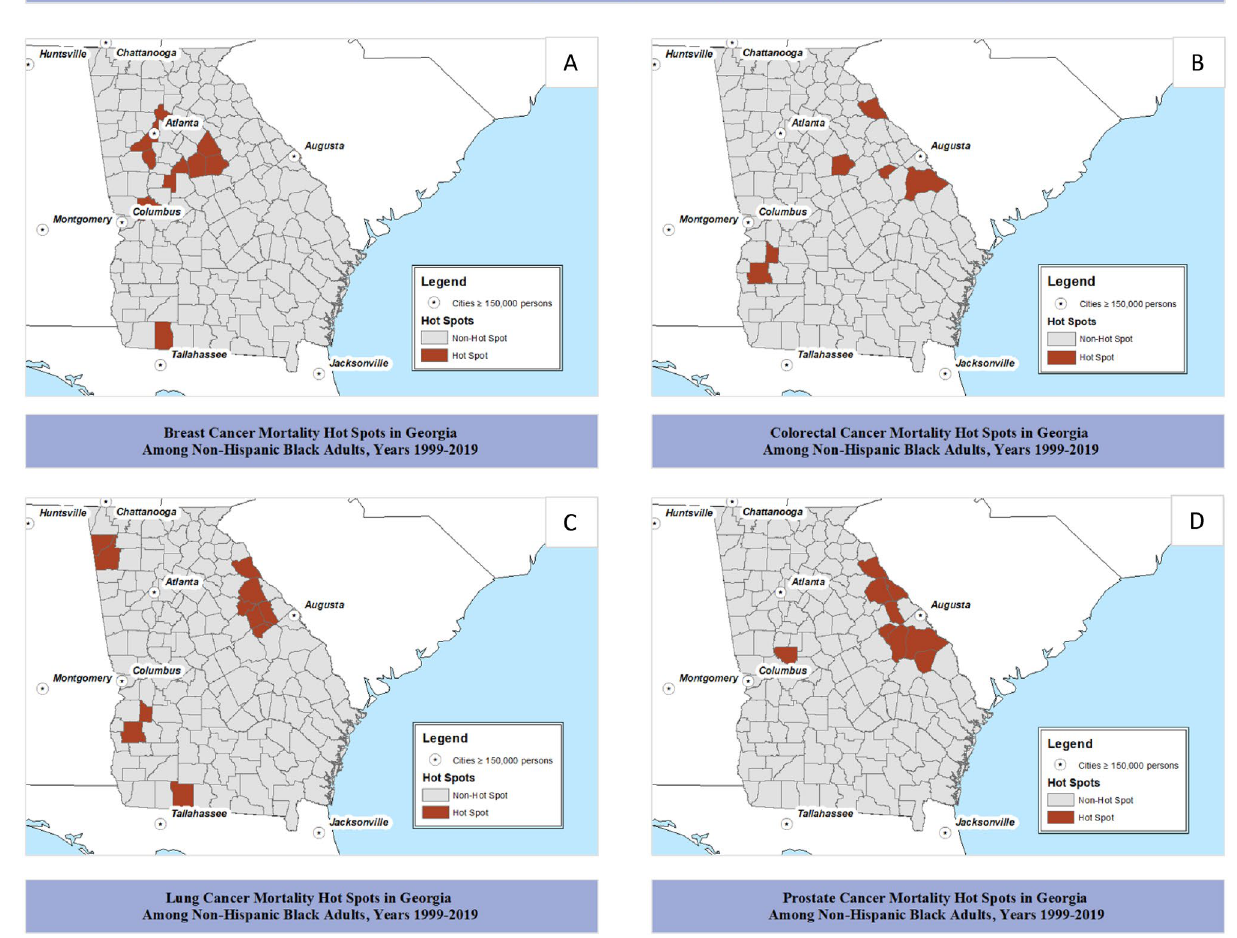
Figure 3. Hot spots of cancer mortality stratified by major cancer types: breast, colorectal, lung, and prostate among NH-black adults in Georgia counties from years 1999 through